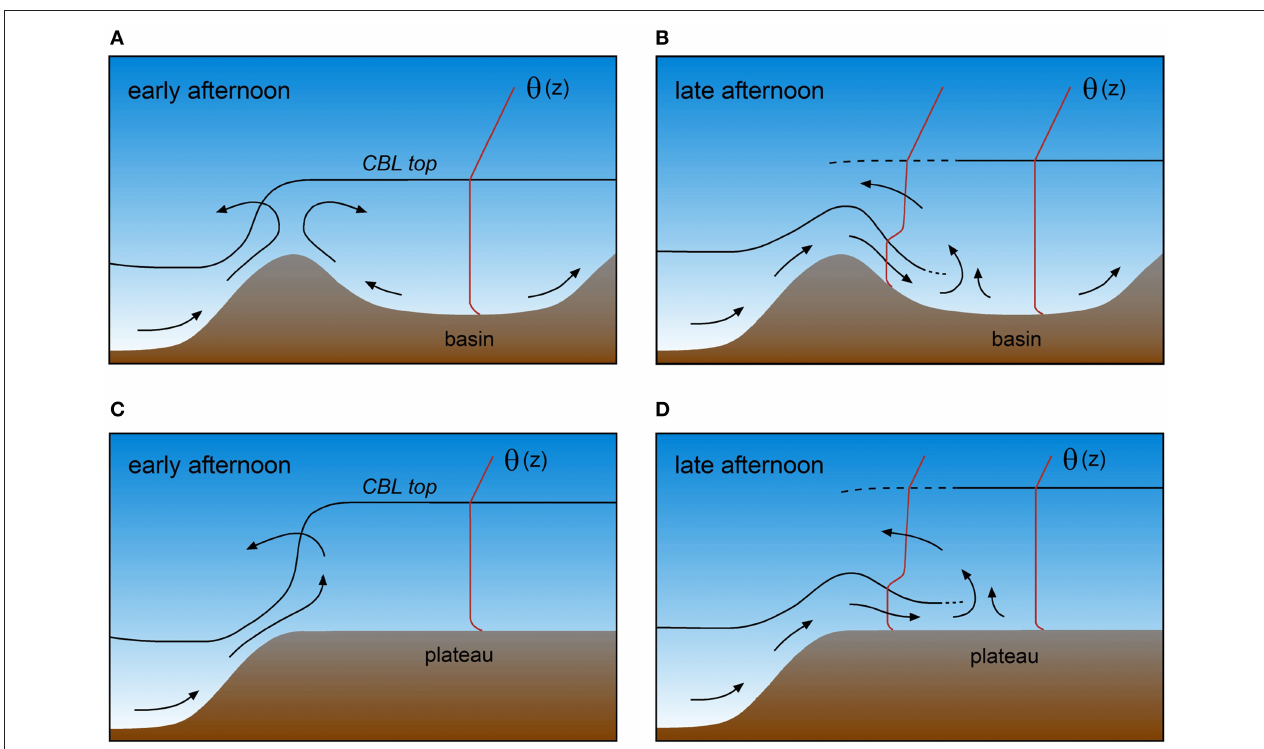
FIGURE 7 | CBL evolution in the afternoon over a mountain basin (A,B) and over a plateau (C,D). Airflow and vertical profiles of potential temperature θ are shown by arrows and red lines, respectively. The intrusion of cold air in the late afternoon leads to shallower CBLs over both basins and plateaus.